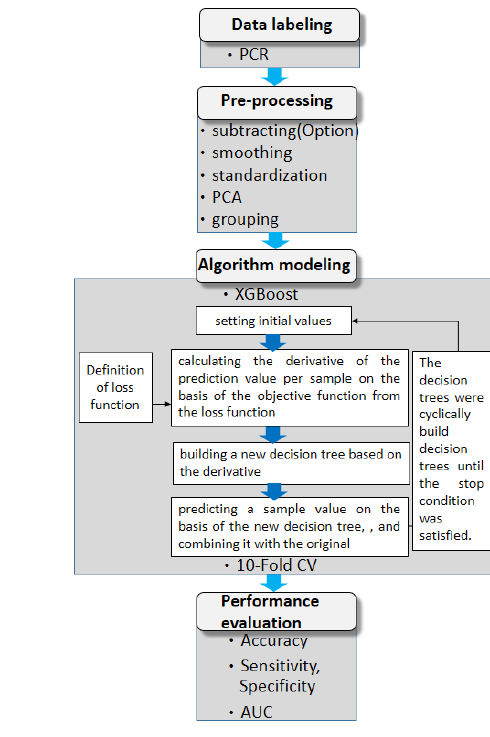
Figure 2. Handheld artificial intelligence (AI) and Internet of Things–based inspection platform. ( a ) Photograph of the system. ( b ) Schematic of the system. ( c ) Icon and main panel of the app, displaying the leaf spectrum under green-light excitation, as measured by the optical probe. ( d ) Schematic of the optical probe and components of the inspection platform.